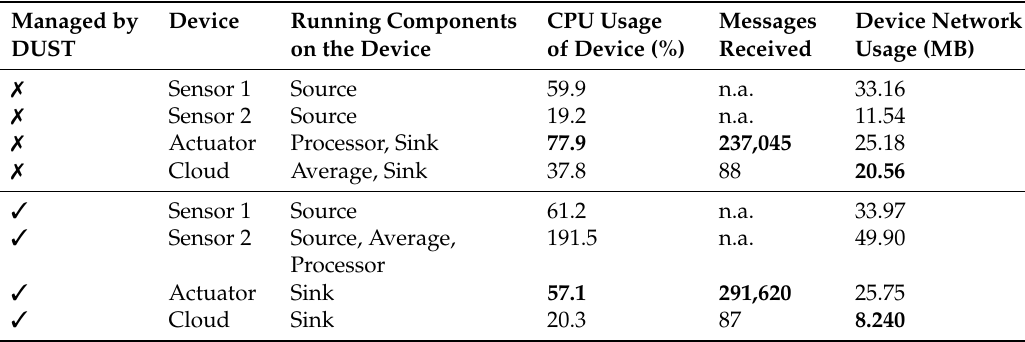
Table 4. Fog computing results of use case 2.